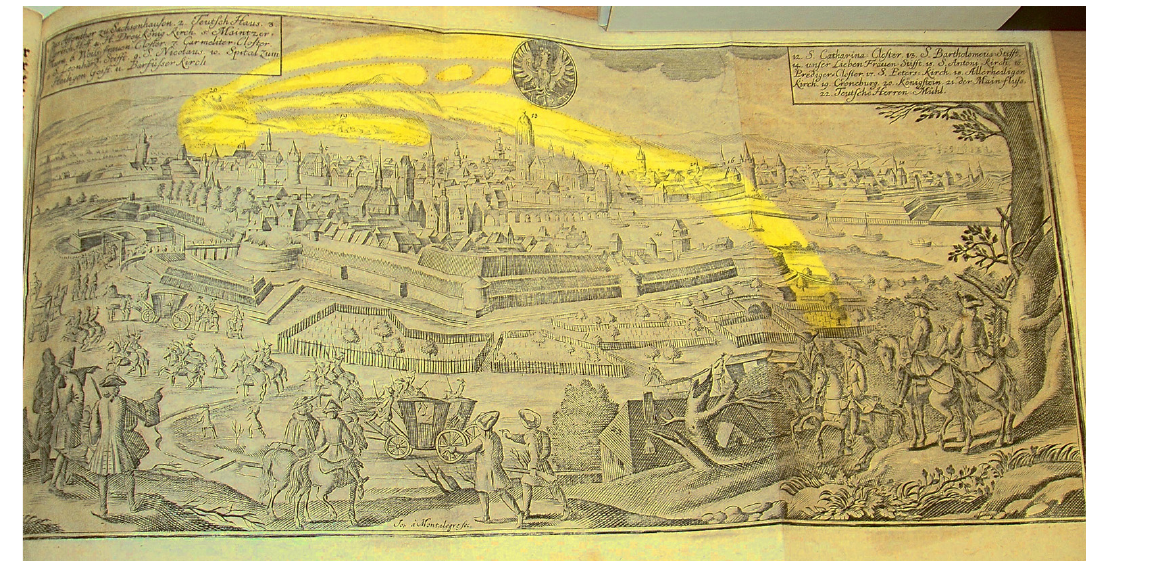
Figure 4. Copper plate of the observation on 16 November 1729. This illustration is remarkable since it is printed in two colours (gray-scales and yellow). It is said in the title page of the booklet “auf Kupfer mit deutlichen Farben delineiret” (on a copper plate marked with clear colours). So Keck may have used an existing copper plate of the city and drew the arcs on it in